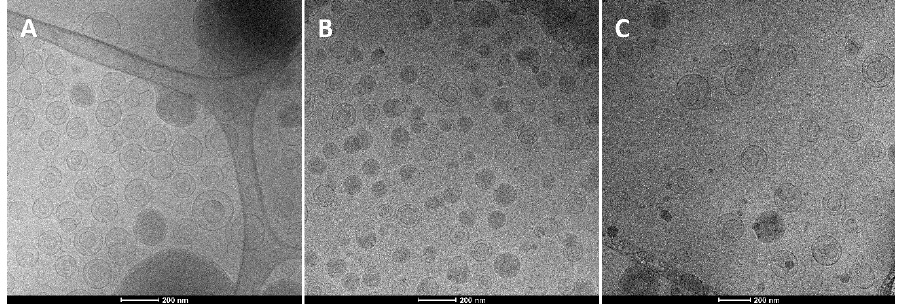
Figure 1. Representative cryo-TEM images of ascorbic acid and tocopherol co-loaded liposomes ( A ), nutriosomes ( B ), and EU-nutriosomes ( C ).